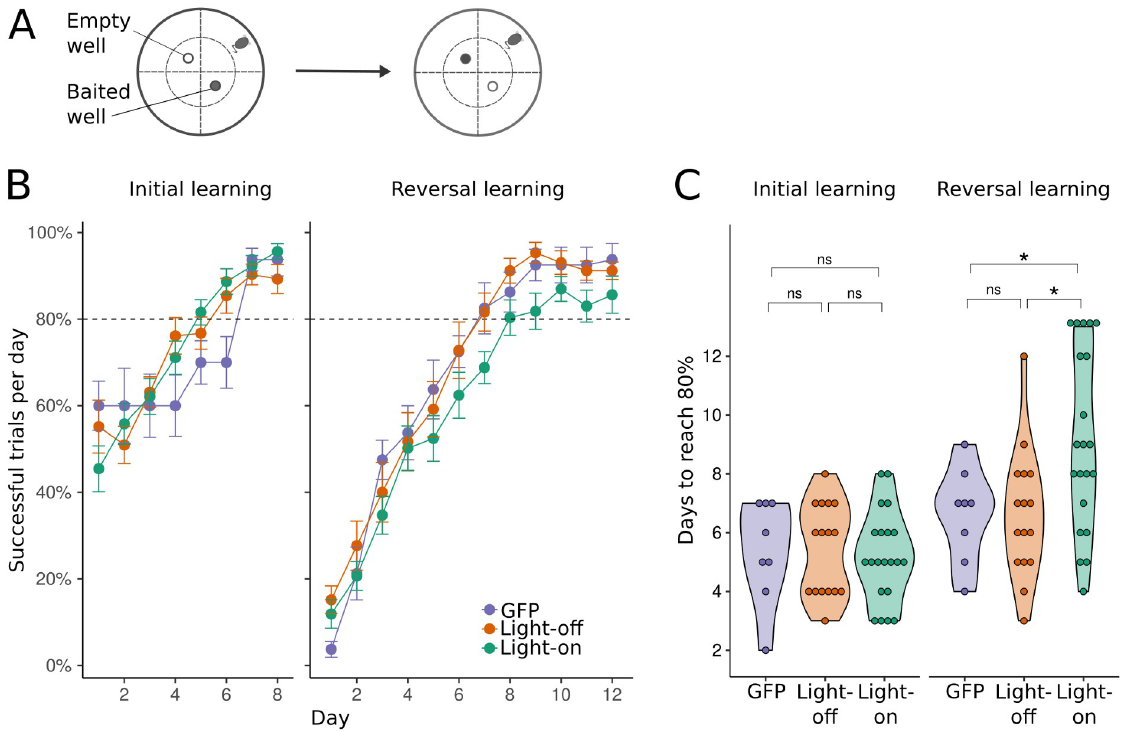
Fig 1. Inactivating cholinergic neurons affects reversal learning. (A) Schematic of the task paradigm. Mice were first trained to locate a baited food well in an open-field (initial learning stage). After 8 days of training, the location of the baited well was shifted to the opposite quadrant, and training proceeded for another 12 days (reversal learning stage). Mice received 10 trials each day. (B) Learning performance across days, averaged over number of mice in each group (GFP control, n = 8; Light-off control, n = 16; Light-on, n = 21). Error bars show SEM. GFP mice were tested in a separate cohort of mice with 5 light-on (ACh-suppressed) mice, and under-performed slightly in the initial learning stage. However their performance was similar to light-off controls in the reversal learning stage, which indicated they had successfully acquired the task. (C) Number of days taken for mice to reach and maintain an 80% success rate.